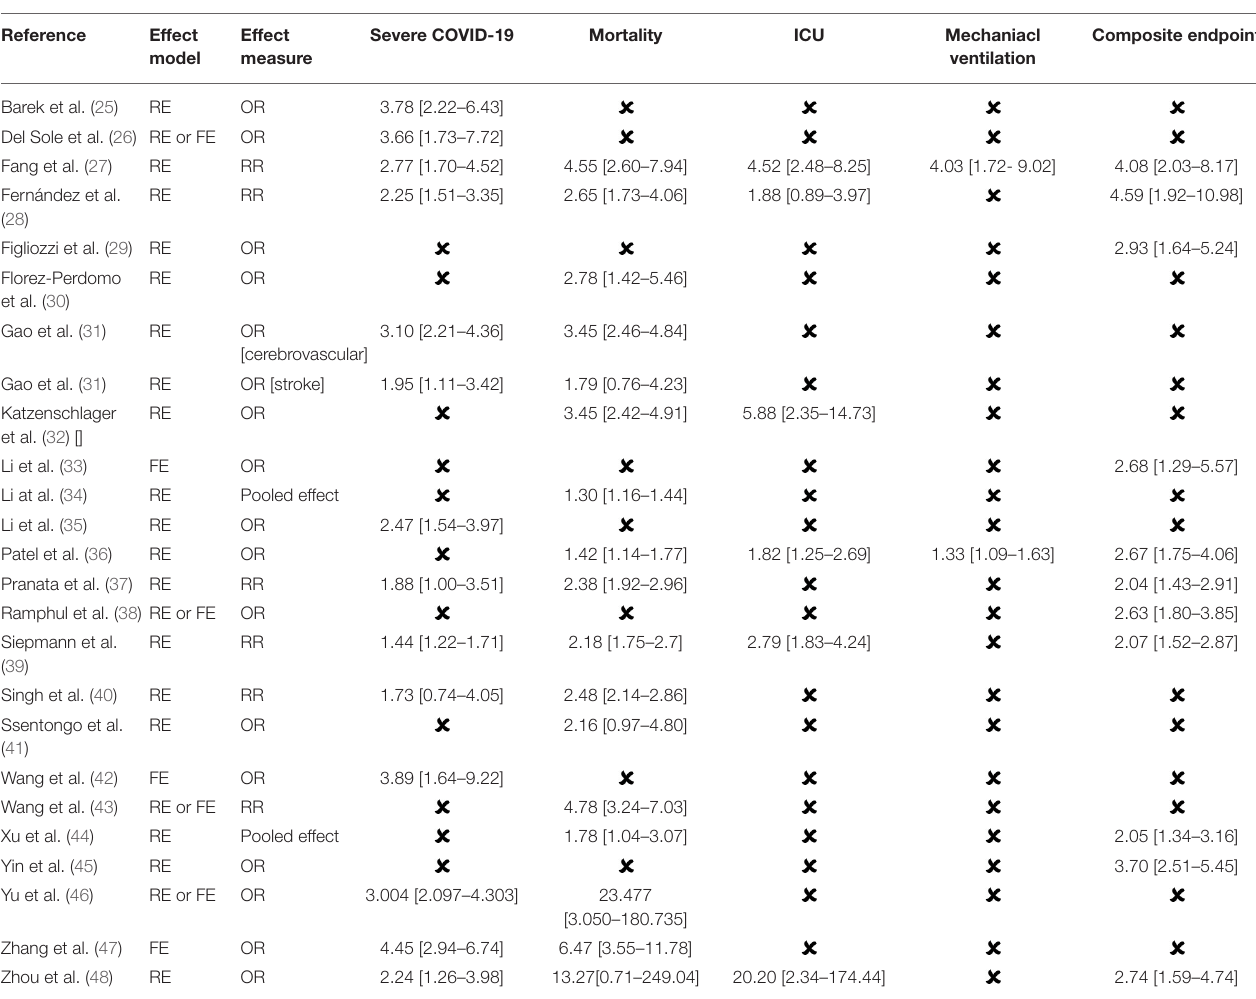
TABLE 5 | Summary of study